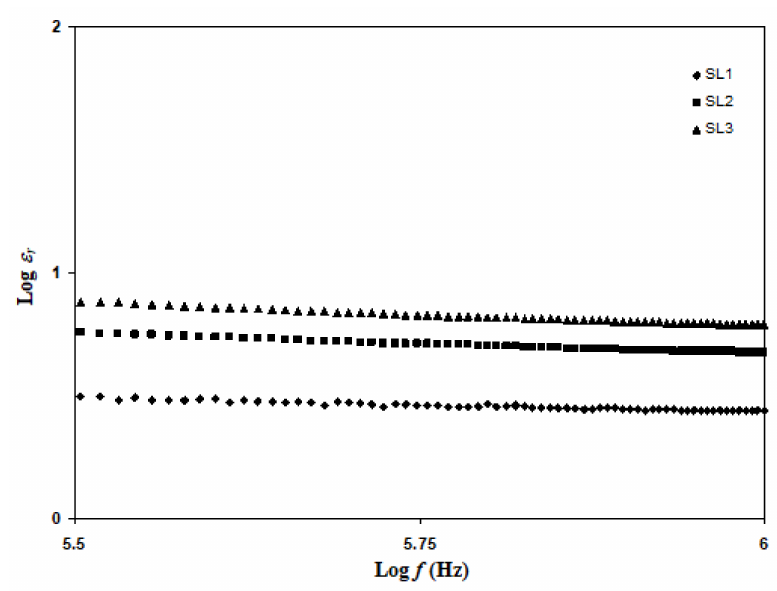
Figure 8. Log ε r vs. log f for SL1, SL2, and